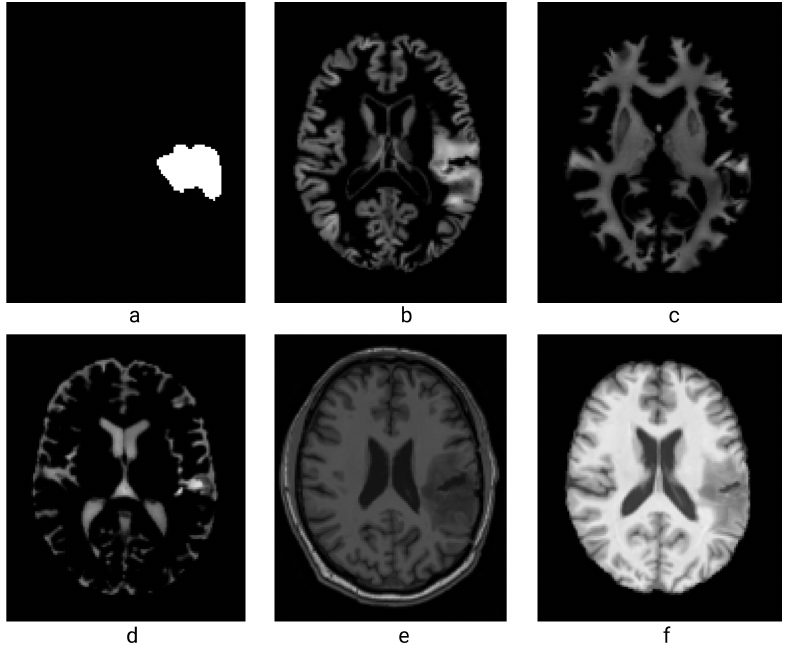
Figure 1. Visual representation of the described data of unhealthy patients in Table 1: ( a ) is the lesion mask, ( b ) is the grey matter mask, ( c ) is white matter mask, ( d ) is cerebrospinal fluid mask, ( e ) is whole brain, cerebrospinal fluid (skull and skin included), ( f ) is whole brain (white and grey